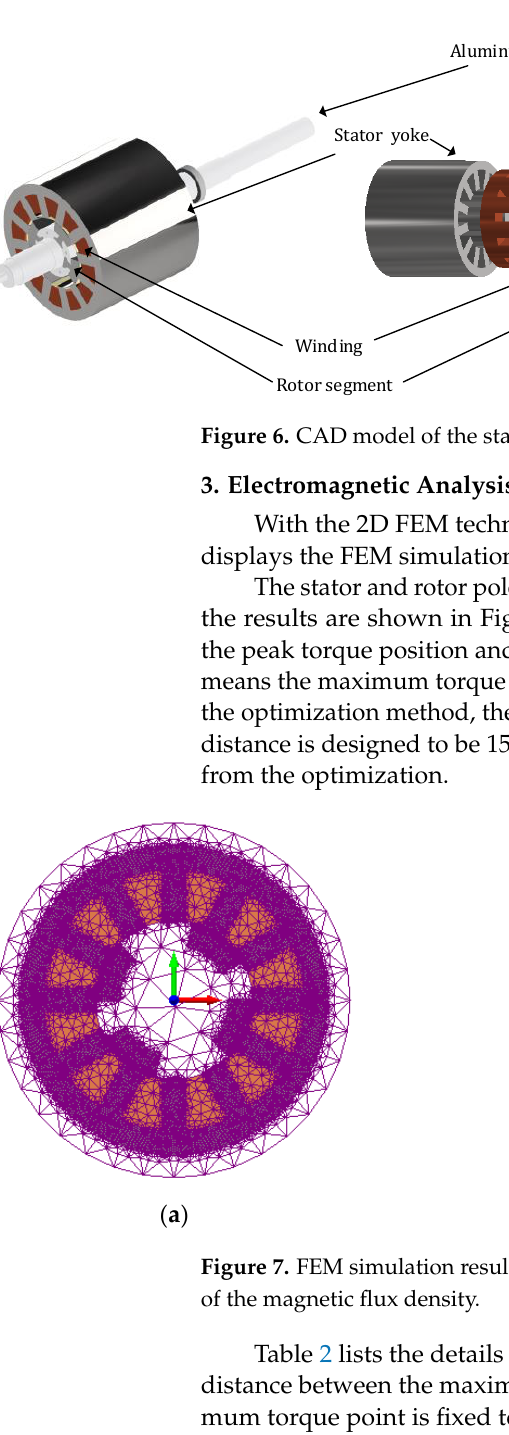
( b ) Figure 8. Optimization of the proposed SRM: ( a ) the optimization results of the torque; ( b ) the opti- mization result of the pole dimensions. Table 2. The details of the optimization methods. Objective Minimization of the distance between the maximum torque point and the 75-degree position in Figure 8a Variable